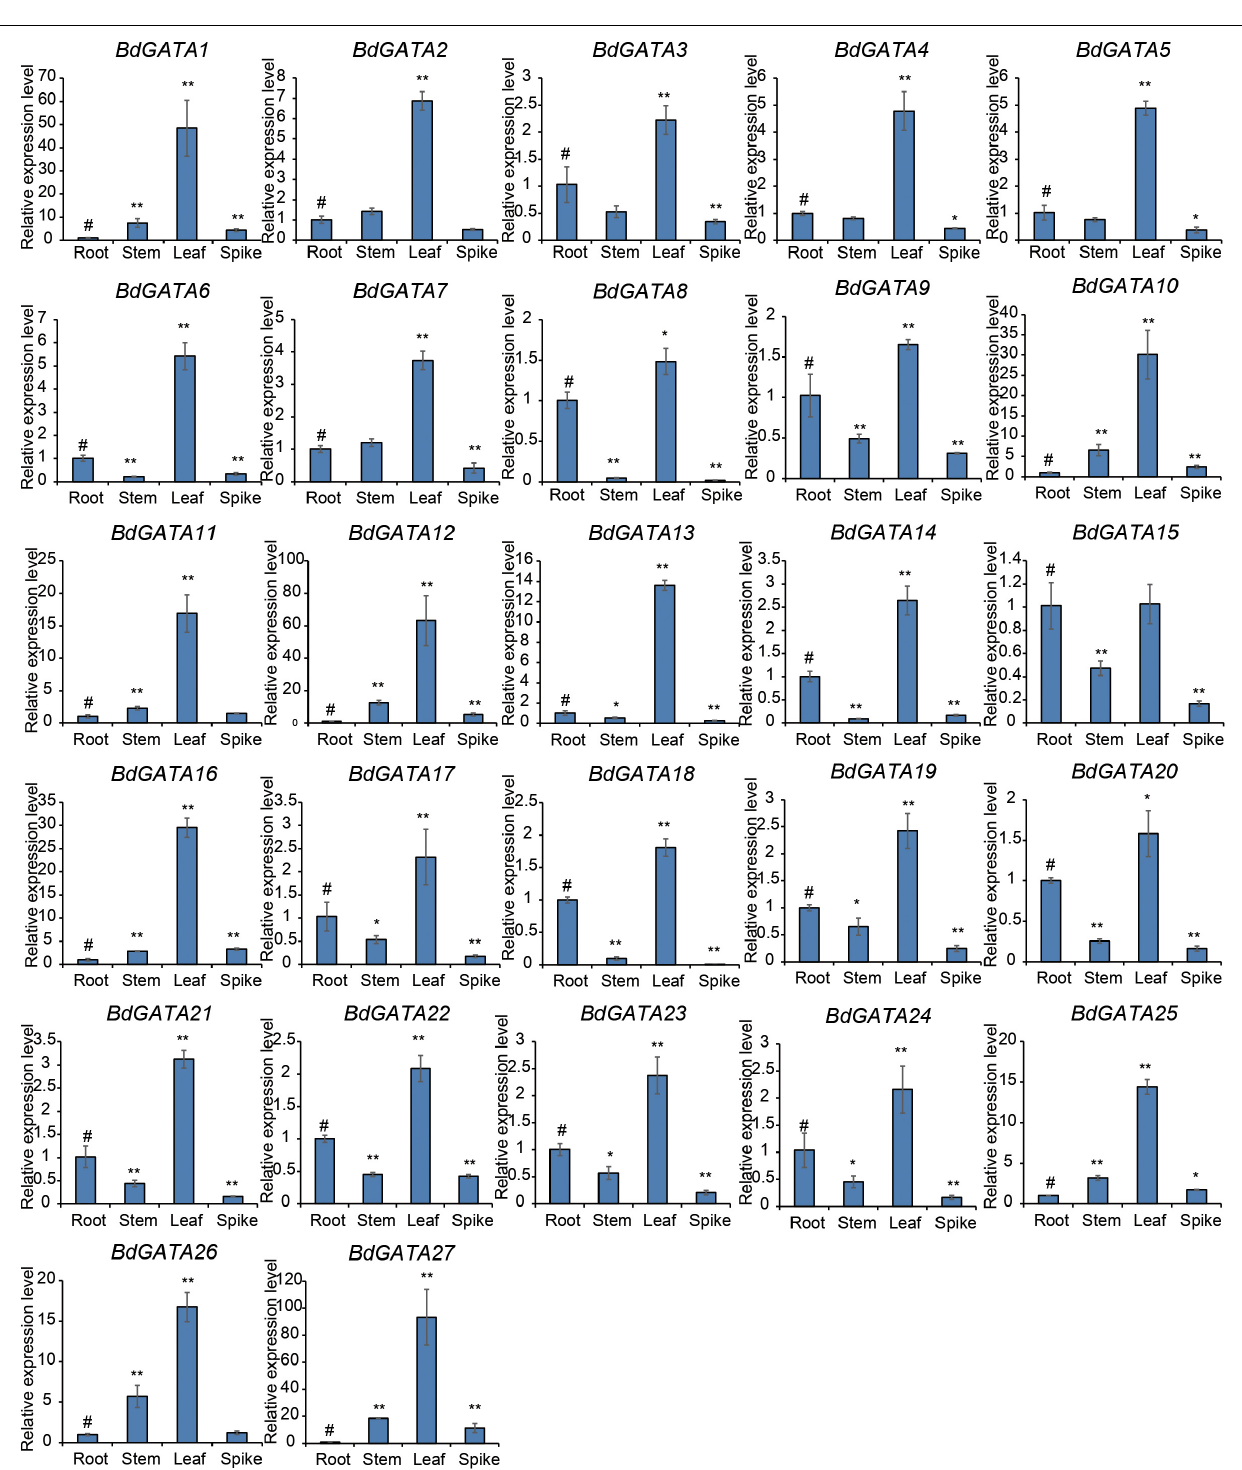
Frontiers in Plant Science |